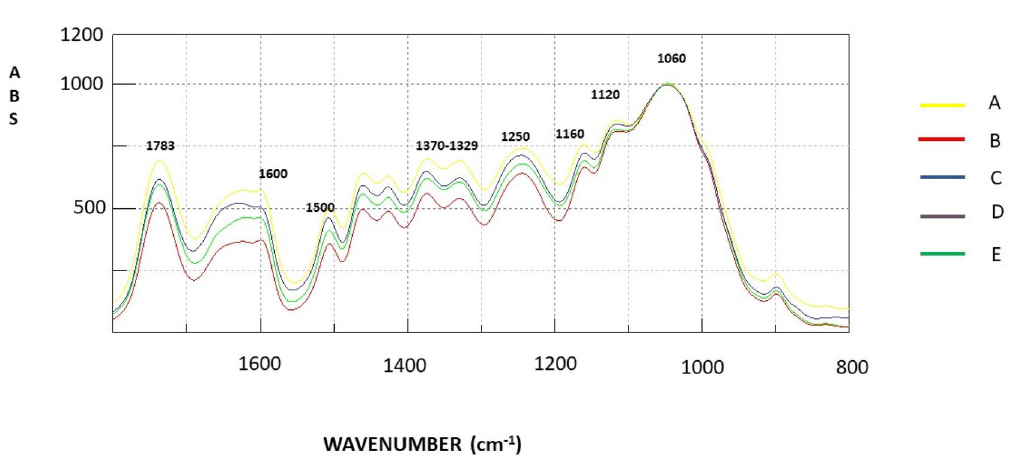
Figure 5. FTIR normalized spectra of A–E areas of chestnut coppices of Amiata mountain of 11–14 years